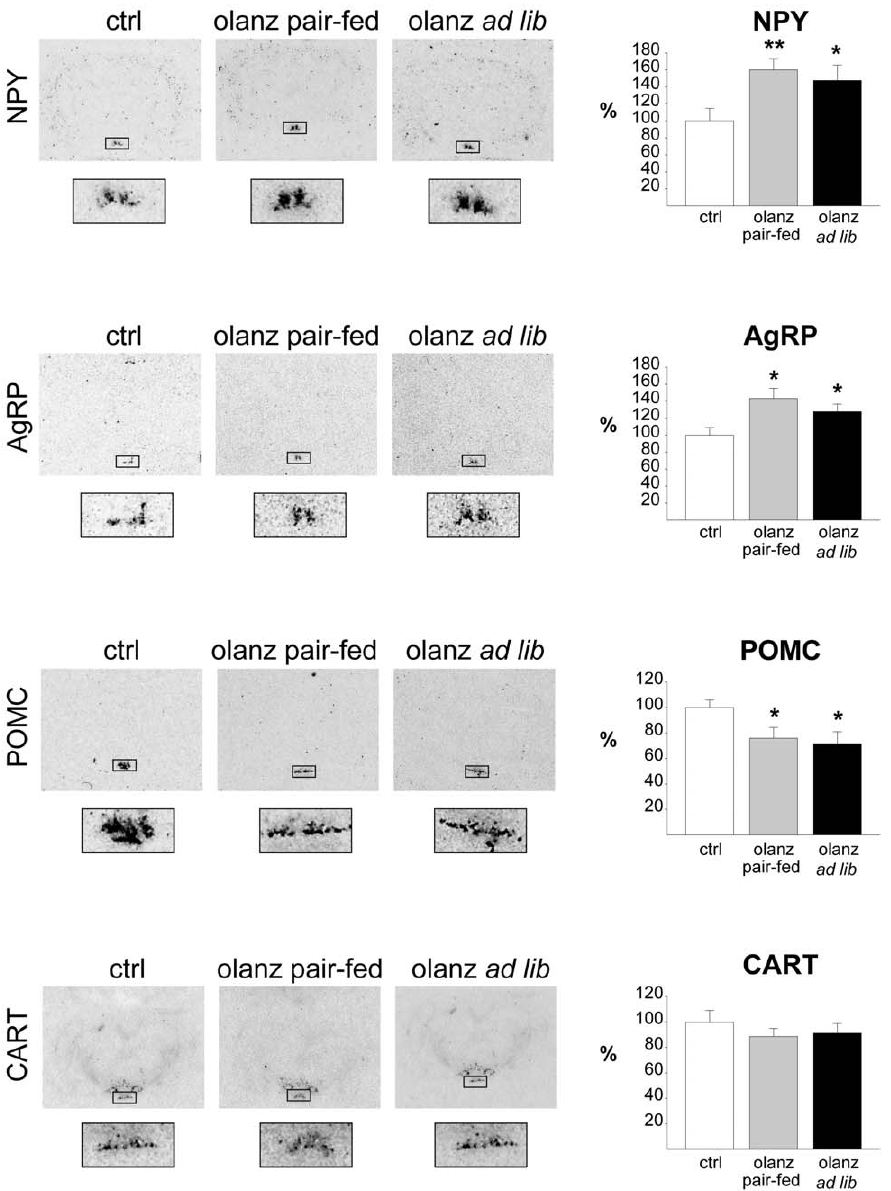
Figure 5. Effect of subchronic olanzapine administration on appetite-regulating neuropeptides. Expression levels of the appetite- regulating neuropeptides in the arcuate nucleus following 5 days of treatment (b.i.d) with vehicle (ctrl), olanzapine with food restriction (olanz pair- fed) or olanzapine with free access to food (olanz ad libitum). Calculations are based on results from groups of rats (n=8) from each treatment group fasted over night and killed in the morning on day 6. Representative images demonstrating the calculated differences were selected. Delineated areas are shown at higher magnification at the bottom. * P # 0.05 vs. vehicle. ** P # 0.01 vs. vehicle. *** P # 0.001 vs. vehicle.